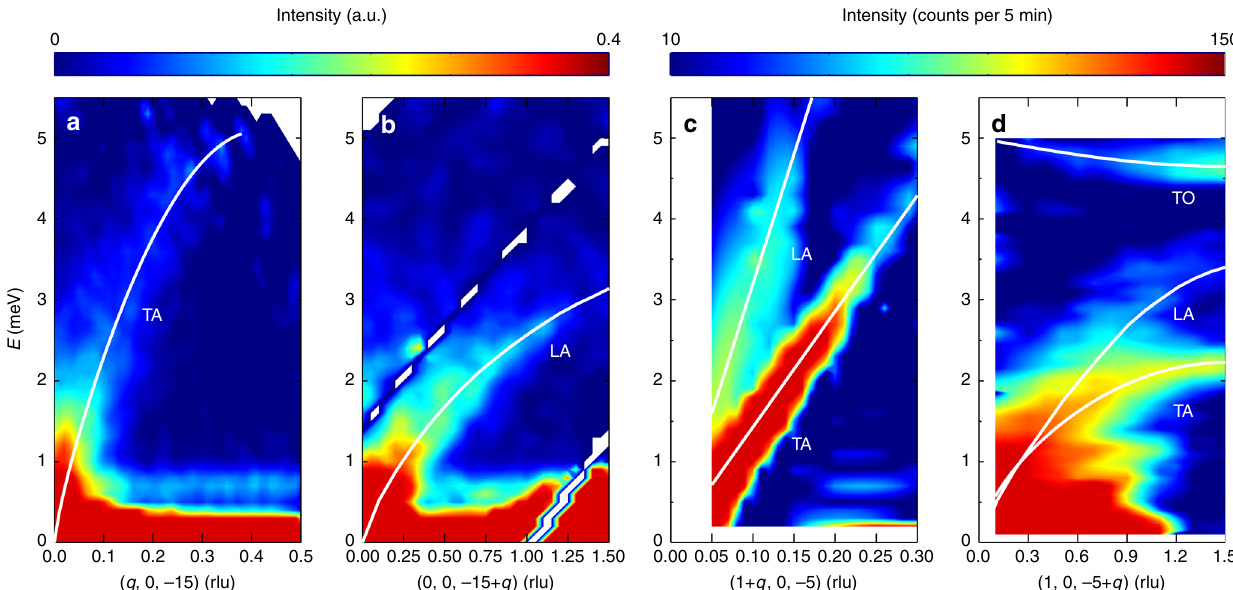
Fig. 2 Phonon dispersions around two Bragg peaks (0, 0, − 15) and (1, 0, − 5) measured at T = 17 K. a , b phonon dispersing from (0, 0, − 15) along the [100] and [001] directions, respectively. c , d , phonon dispersing from (1, 0, − 5) along the [100] and [001] directions, respectively. The data plotted in a , b were collected on a time-of- fl ight (TOF) spectrometer AMATERAS, and those in c , d were collected on a triple-axis spectrometer (TAS) PANDA. For the TOF data plotted in a , b , which are the phonon dispersions along one direction, one needs to sum over intensities for a certain thickness along the other two directions to improve the statistics. The data plotted against the H direction in a were obtained by integrating the intensities in ( q , 0 + K , − 15 + L ) with a thickness of K and L ranging from − 0.1 to 0.1 rlu, and − 16 to − 14 rlu, respectively. Those in b were integrated with H = K = [ − 0.05, 0.05] rlu. E and q represent the phonon energy and momentum, respectively. TA, LA, and TO represent transverse acoustic, longitudinal acoustic and transverse optic modes, respectively. Solid lines are the dispersions obtained by fi tting the energy scans at a series of q s as shown in Fig. 3. The white streaks along the diagonal direction in b were due to the lack of detector coverage wherein